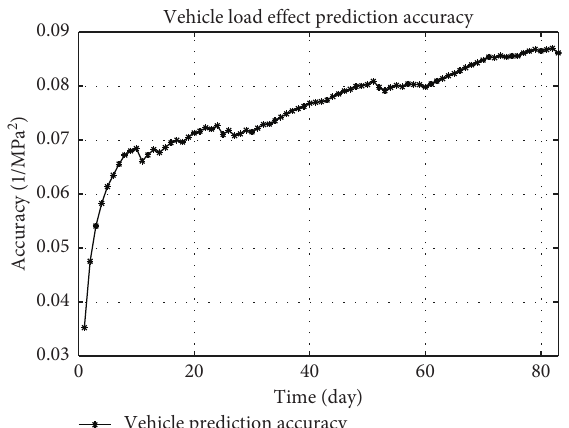
Figure 7: Prediction precision of vehicle load effects.